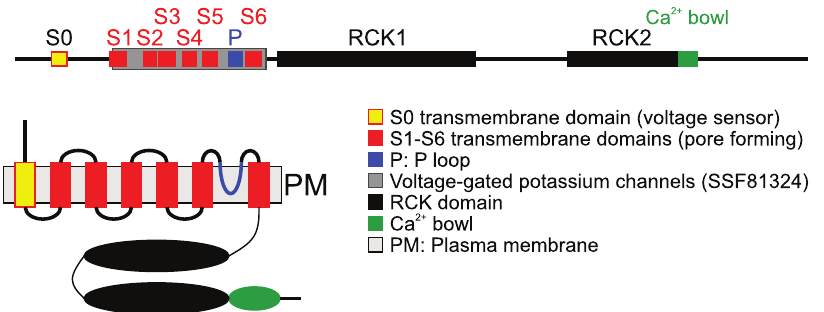
Fig 4. Schematic drawings showing domain composition (A) and topology in the plasma membrane of a SLO-1 subunit (B). The scheme in (A) is drawn to scale based on Onchocerca volvulus SLO-1a (GenBank accession number: MW039265; the protein contains 7 transmembrane domains. The transmembrane domains S2–S4 contain charged amino acids and function as voltage sensor, while S5 and S6 are involved in building the pore. For this purpose, 4 subunits form a tetramer. The P loop is involved in tetramer formation and pore building. The 2 RCK domains and the Ca 2+ bowl are involved in regulation of conductance by intracellular Ca 2+ levels. P loop, pore-forming loop; PM, plasma membrane; RCK, regulator of potassium conductance; SLO-1, slowpoke big K + conductance channel.